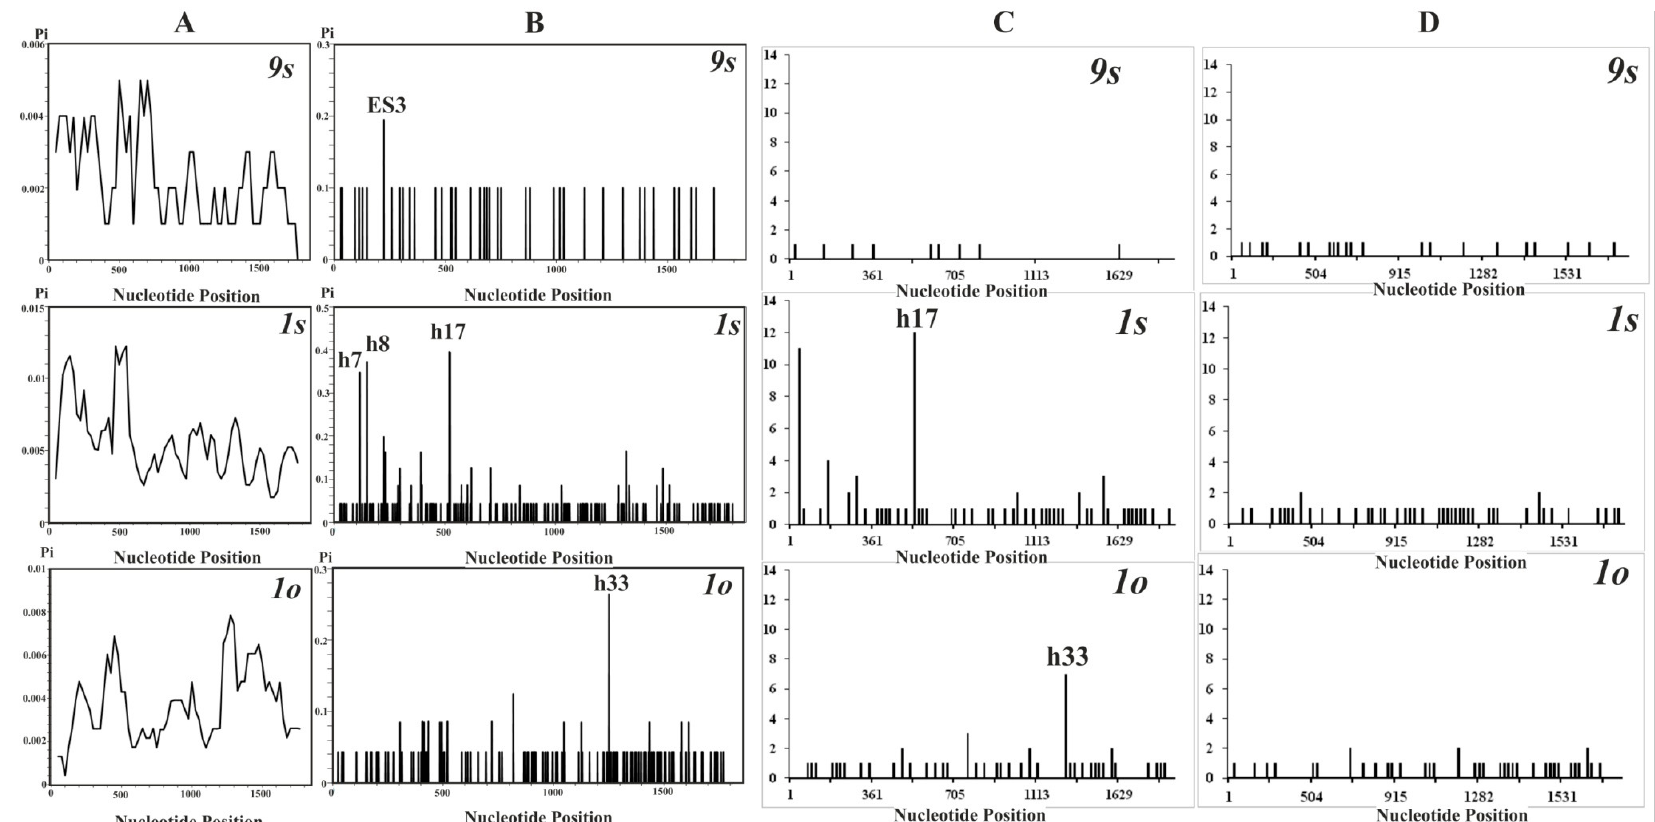
Figure 3. The 18S rDNA sequence variation in the Panax ginseng cell cultures. ( A ) Distribution patterns of all nucleotide substitutions along the gene as computed using the sliding-window option. Histograms for hotspots of variation for ( B ) all nucleotide substitutions, and for sites associated with ( C ) cytosine methylation and ( D ) DNA amination.